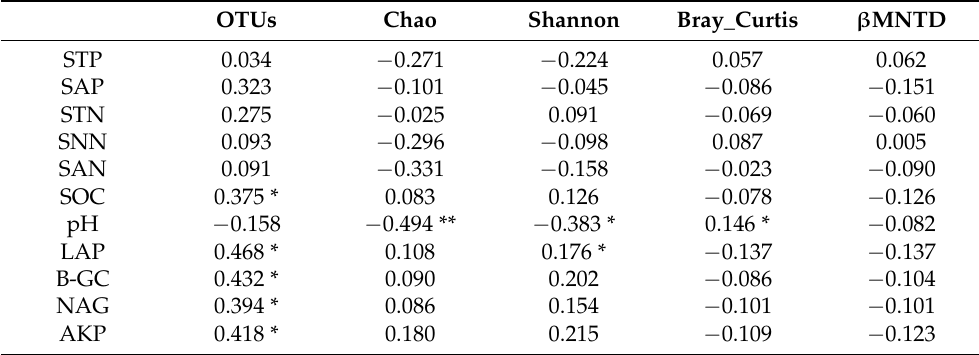
Table 1. Correlation analysis between indicators characterizing the structure of soil bacterial commu- nities and soil chemical properties. OTUs Chao Shannon Bray_Curtis β MNTD STP 0.034 − 0.271 − 0.224 0.057 0.062 SAP 0.323